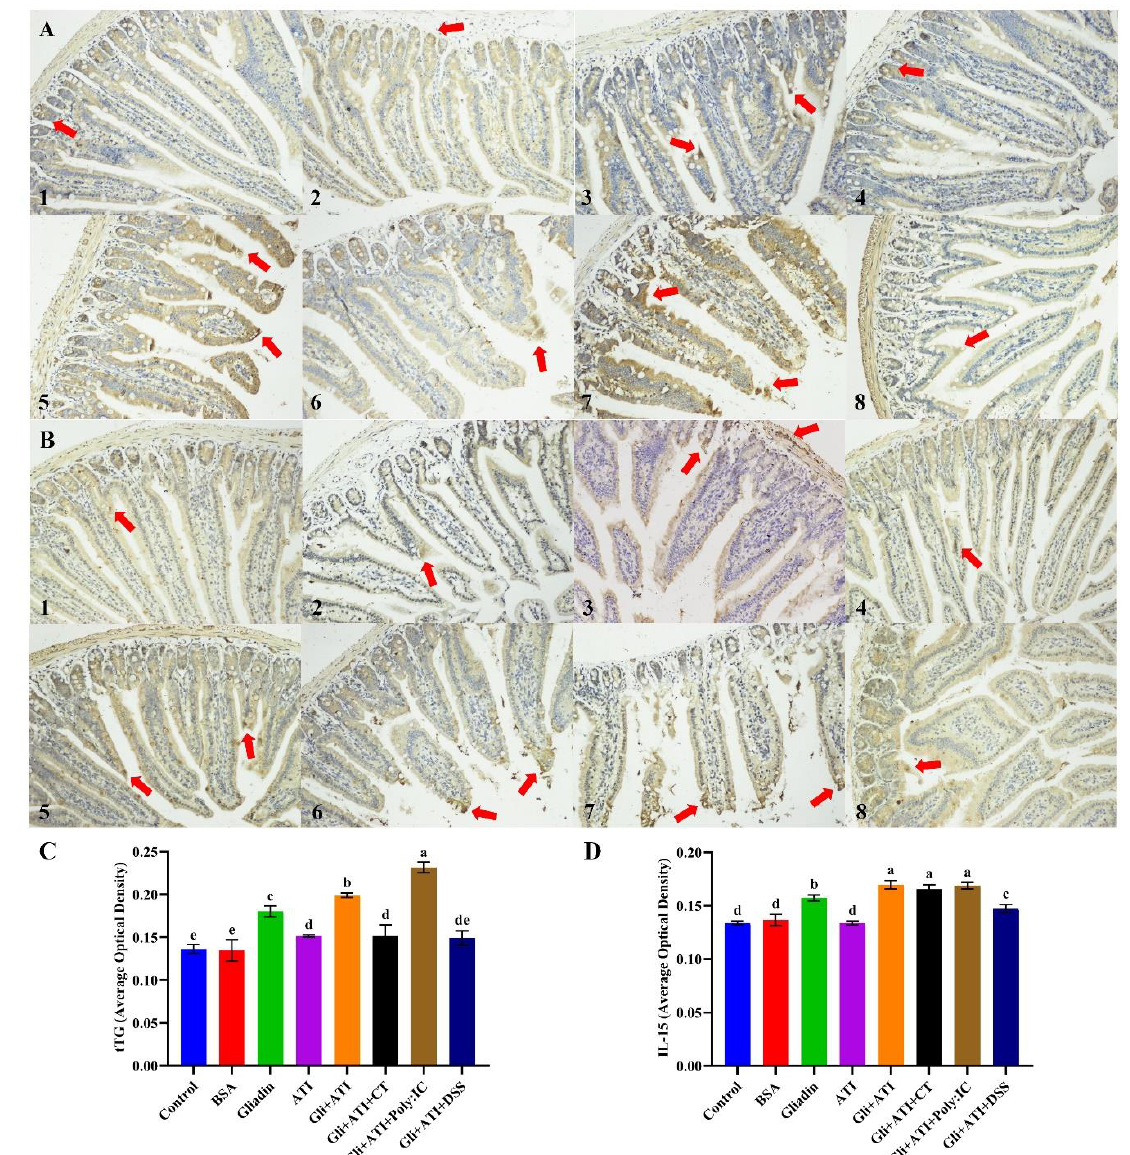
Figure 4. Immunohistochemistry analysis of tissue transglutaminase ( A ) and IL-15 ( B ) in jejunum tissue sections: (1) Control group; (2) BSA group; (3) Gliadin group; (4) ATI group; (5) Gli+ATI group; (6) Gli+ATI+CT group; (7) Gli+ATI+Poly:IC group; (8) Gli+ATI+DSS group. ( A , B ) are the fields of view at 200 × lens. The average optical density of tissue transglutaminase ( C ) and IL-15 ( D ). Different parts of the same tissue would be analyzed in order to obtain reliable results. Different letters represent significant differences ( p < 0.05) between